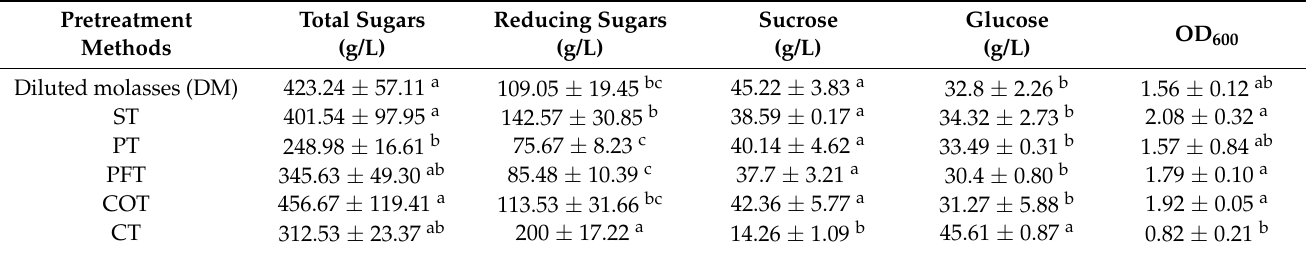
Table 2. Change in the composition of molasses after